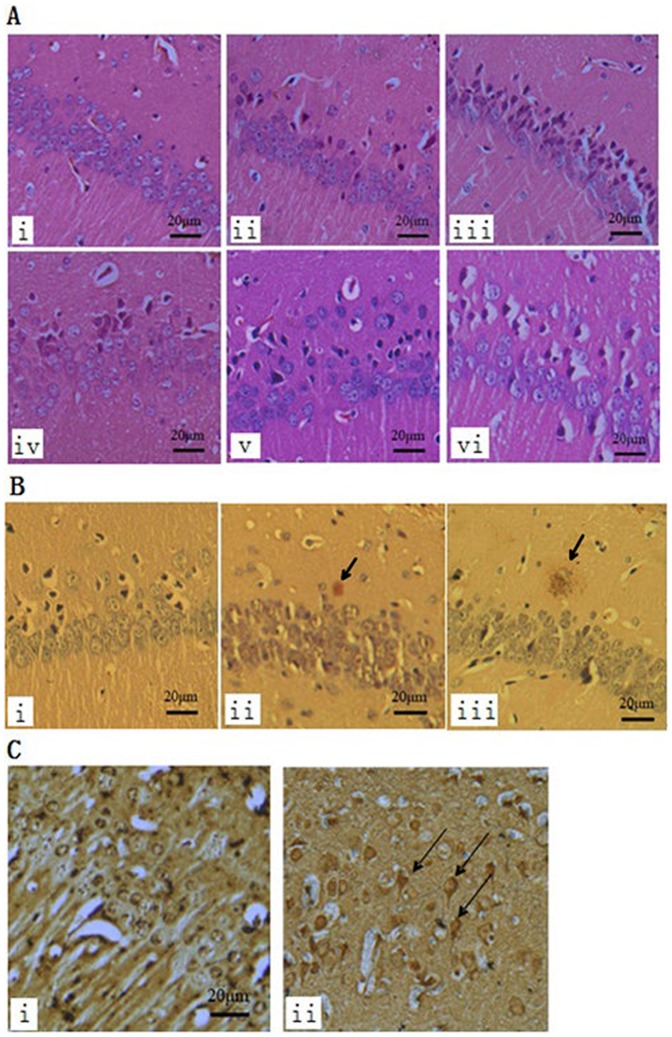
Histopathological architecture of the hippocampus.A: HE staining of the hippocampus (magnification x 400 in A–E) revealed the progression of neuronal apotosis. (i) control group: the neurons were intact and arrange tightly; (ii) model group (on day 30): some densely stained neurons were presented; (iii, iv) model group (on day 40 and day 50): long length administration of drug markedly increased the number of damaged pyramidal cells in the hippocampus; (v, vi) model group (on day 60 and day70): pyramidal neurons either presented a densely stained shrunken appearance with minimal cytoplasm or had disappeared and the cell array became sparse. B: Congo red staining of the hippocampus. (i) control group: normal cellular distribution without amyloid deposition; (ii, iii) model group (on day 60 and 70): presented a collection of orange amylaceous aggradation-amyloid deposition (arrows). C: Bielschowsky silver impregnation of the hippocampus. (i) control group: no evidence of neurofibrillary tangles; (ii) model group (on day 70): neurofibrillary tangles were presented and stained neuropil threads (arrows).